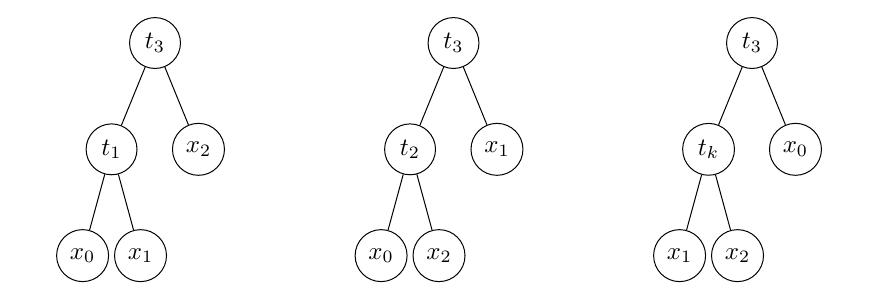
Figure 1: Computation trees of gate t